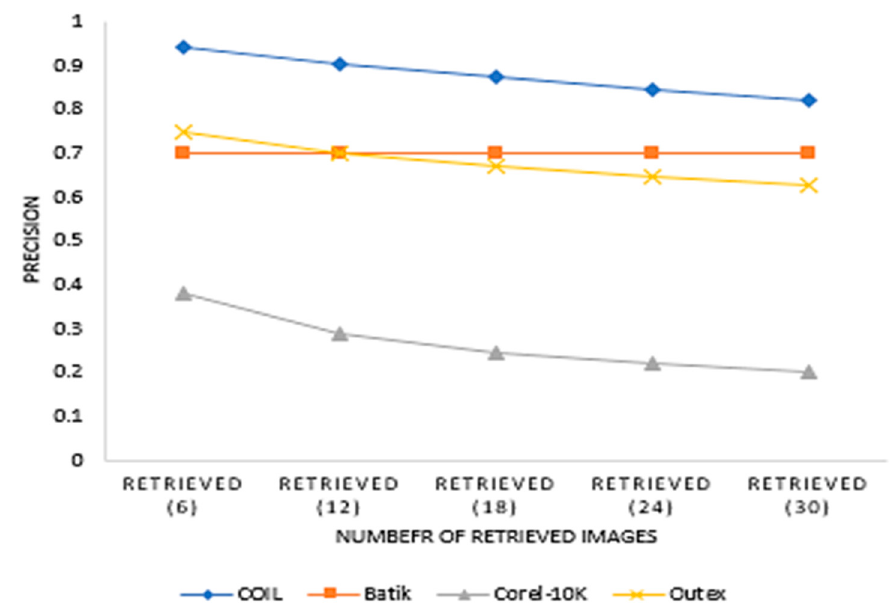
Figure 5. Average precision for various retrieved values for the four datasets.